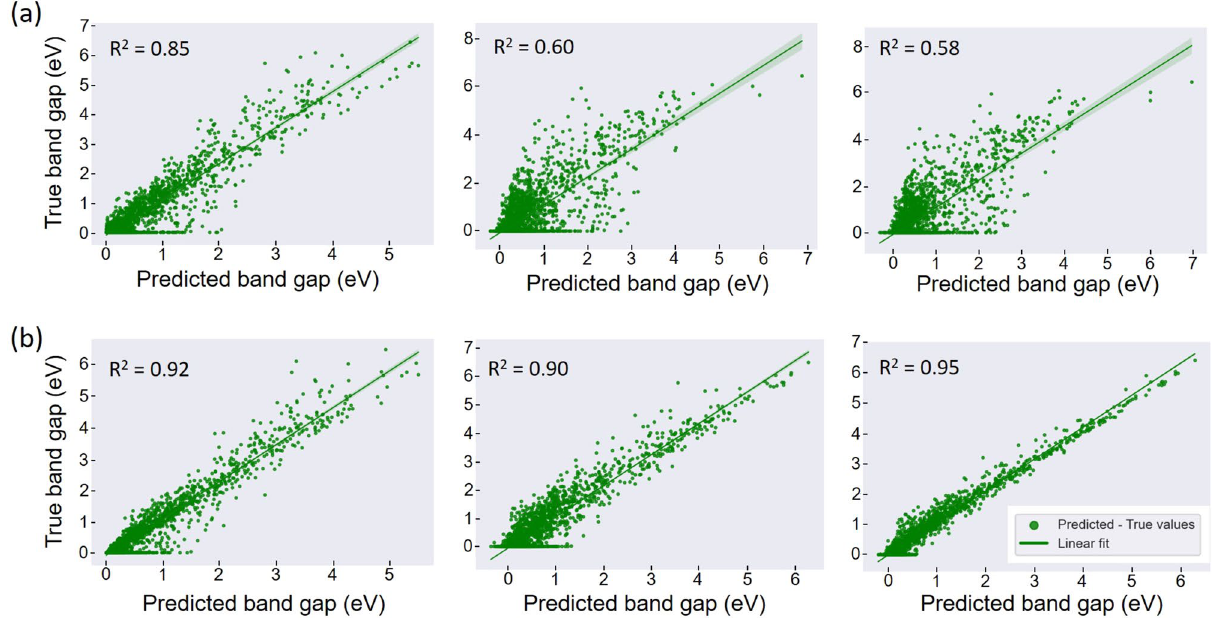
Figure 2. Visualization of the predicted and true values of the band gap by using the feature set 1 ( a ) and the 2 feature set 2 ( b ) for RF, GB, XGB models. The values of R are also shown. The lines shown with confidence interval of 95% are linear regression of the data points and aid as a guide to the eye.